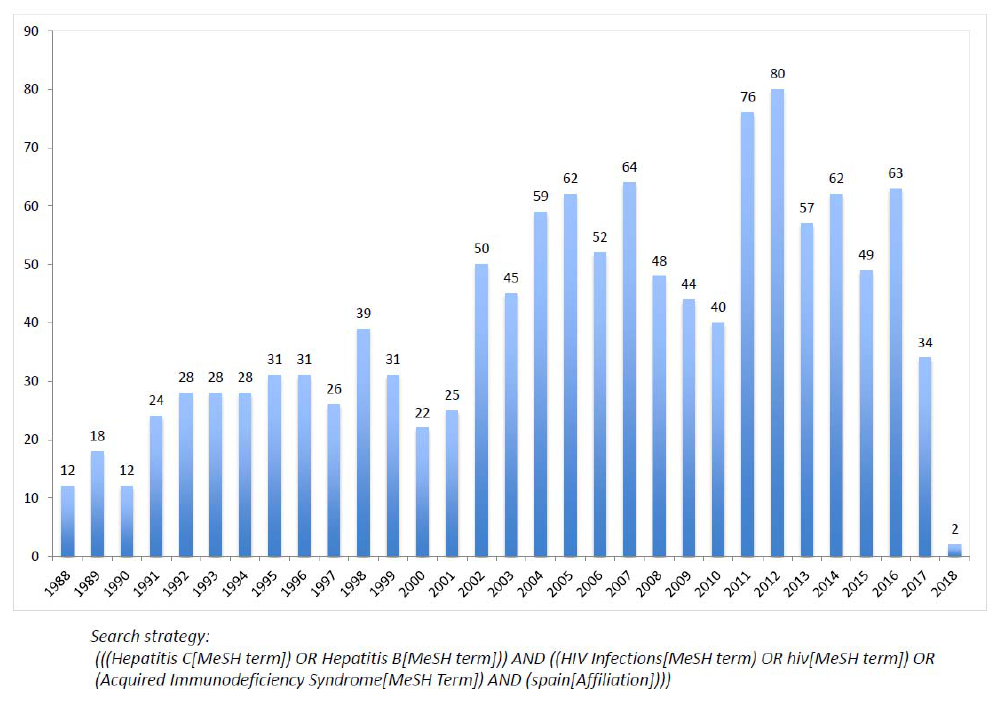
Figure 2. Number of publications recorded yearly in PubMed on HIV and hepatitis B/C coinfection by Spanish authors.